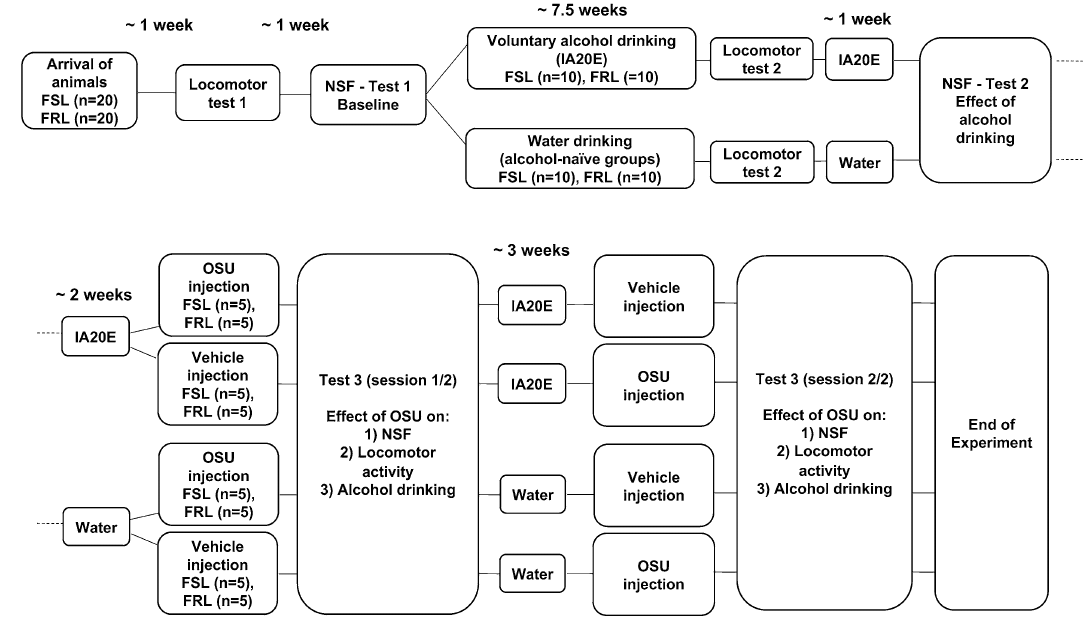
Figure 1. Schematic experimental timeline. A total of n = 20 control-FRL (the Flinders Resistant Line) and n = 20 FSL (the Flinders Sensitive Line—a genetic rat model of depression) animals were used. Following locomotor test 1 and NSF test 1, FSL and FRL animals were divided into two groups, i.e., one group that had access to alcohol under the IA20E protocol (n = 10 animals per FSL and FRL groups) and one that had access to water only (n = 10 animals per FSL and FRL groups). The NSF test 3 was conducted during two test sessions, i.e., OSU session 1/2 and OSU session 2/2, separated by approx. 3 weeks of access to IA20E or water. For NSF test 3, all animals were given both treatments [i.e., OSU and vehicle (saline)] and were randomized to receiving either OSU or vehicle at the first test session. Single OSU or vehicle injections were given 60 min before the start